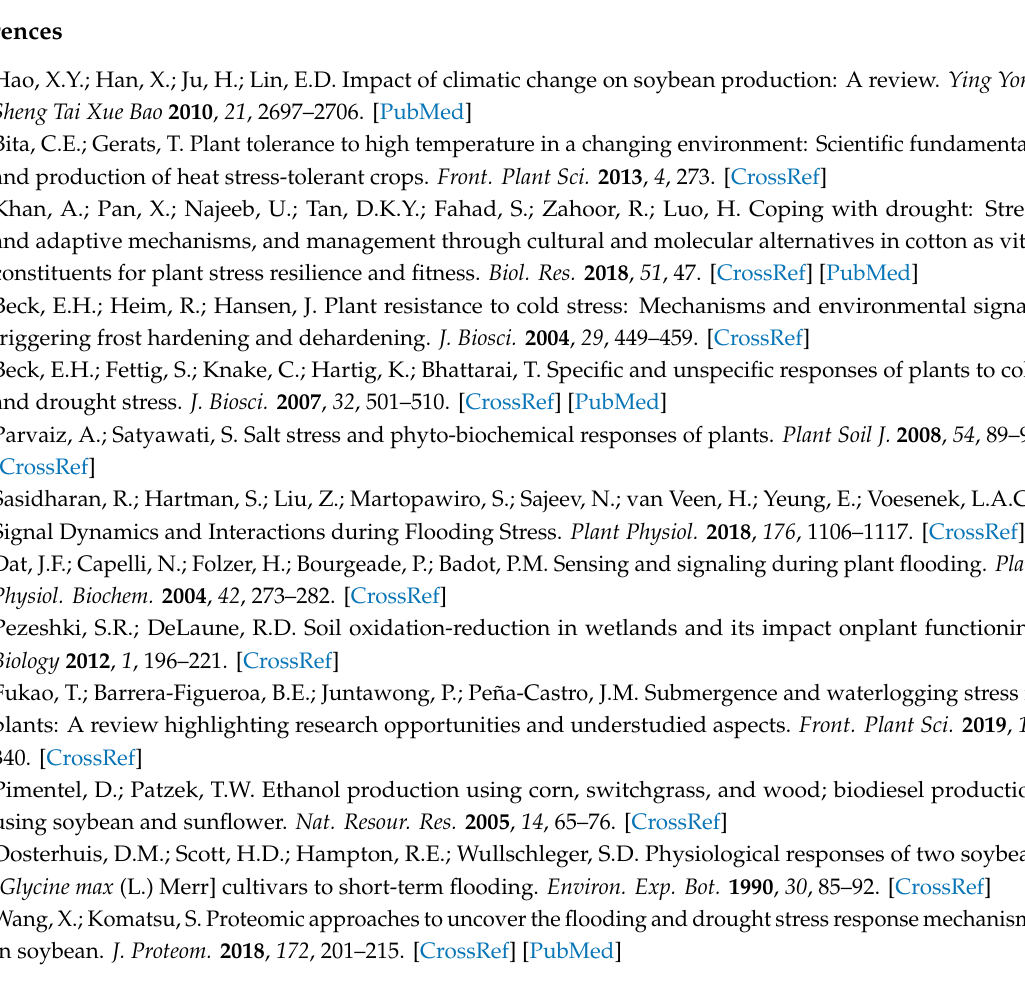
Table S1. List of identified proteins in flooding-stressed soybean treated with silver NPs, nicotinic acid, and KNO3 compared to control. Figure S1. Overview of data of total proteins from 6 samples based on PCA. Figure S2. Flooding treatment of